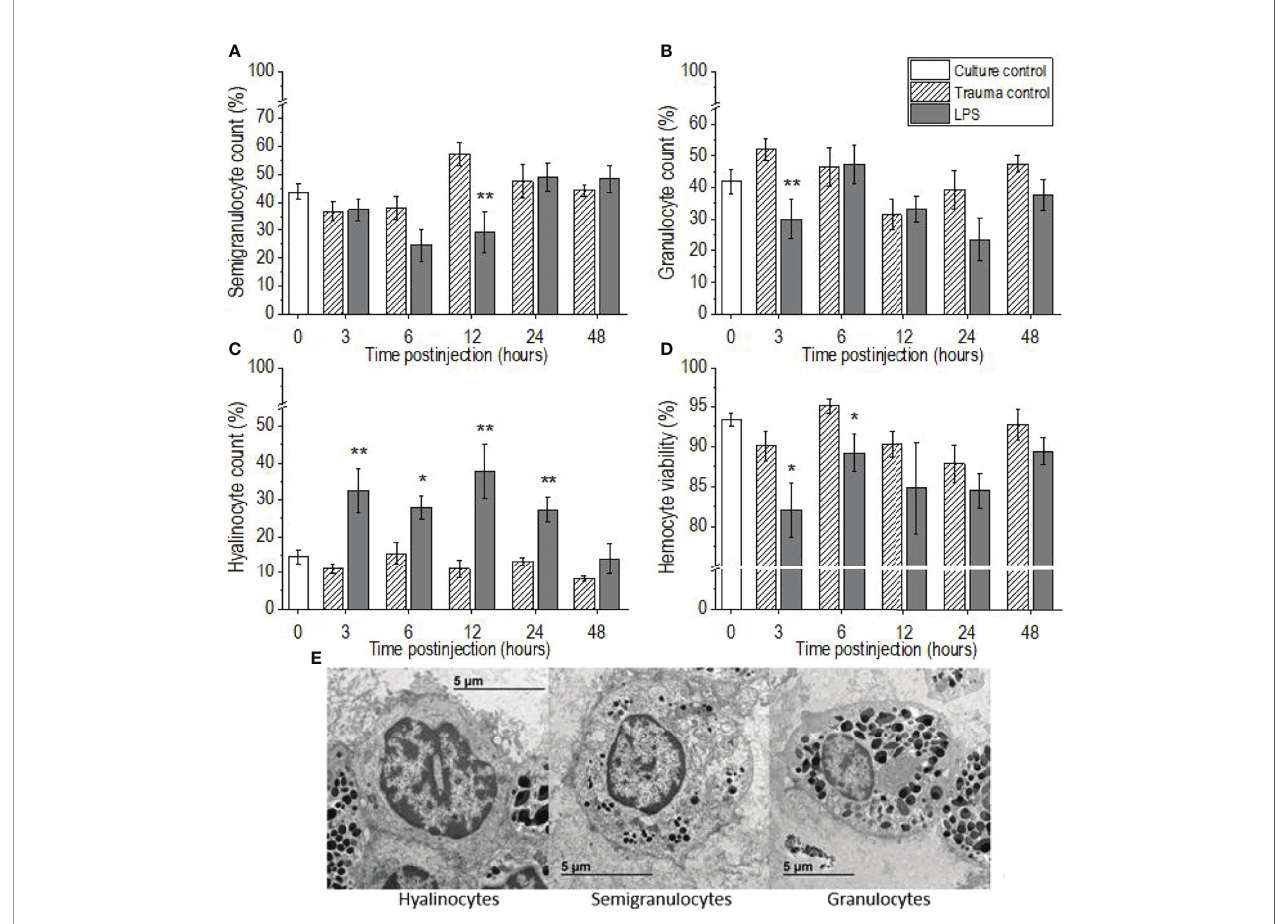
FIGURE 2 | Time-courses of differential hemocyte counts (A – C) and hemocyte viabilities (D) for the hemolymph of P. scaber injected with 0.5 m L DPBS (trauma control) and lipopolysaccharide (LPS; 0.5 m g/ m L). (A – C) Relative proportions of semigranulocytes (A) , granulocytes (B) , and hyalinocytes (C) . Culture control represents P. scaber not subjected to any injection. Data are means ± SE. *p <0.05; **p <0.01, versus trauma control (n = 10). (E) Transmission electron micrograph of the three main types of hemocytes (hyalinocytes, semigranulocytes, granulocytes) in the hemolymph of P. scaber